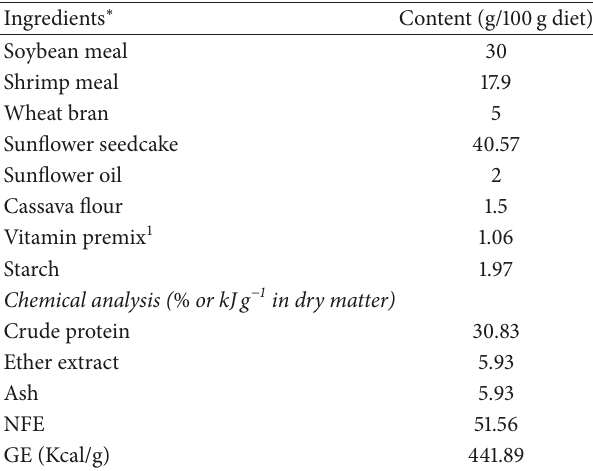
Table 1: Ingredients and nutrient composition of the basal diet of O. niloticus